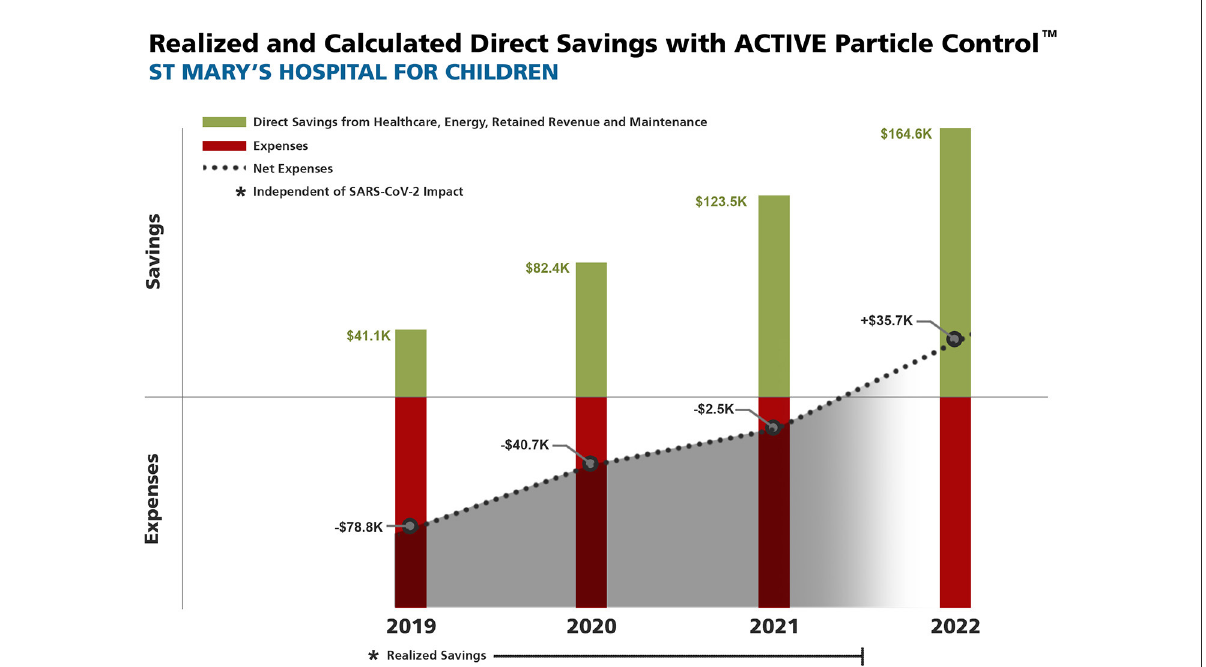
FIGURE2 Realized and calculated Cumulative Direct and Net Savings from healthcare-associated infection (HAI) avoidance, energy and maintenance savings, and retained revenue with ACTIVE Particle Control TM (APC) technology. All HAI data collected prior to COVID-19. *Does not include broader additional healthcare system savings of $25,592 each year, nor the annual 52 ton reduction in carbon dioxide generation.